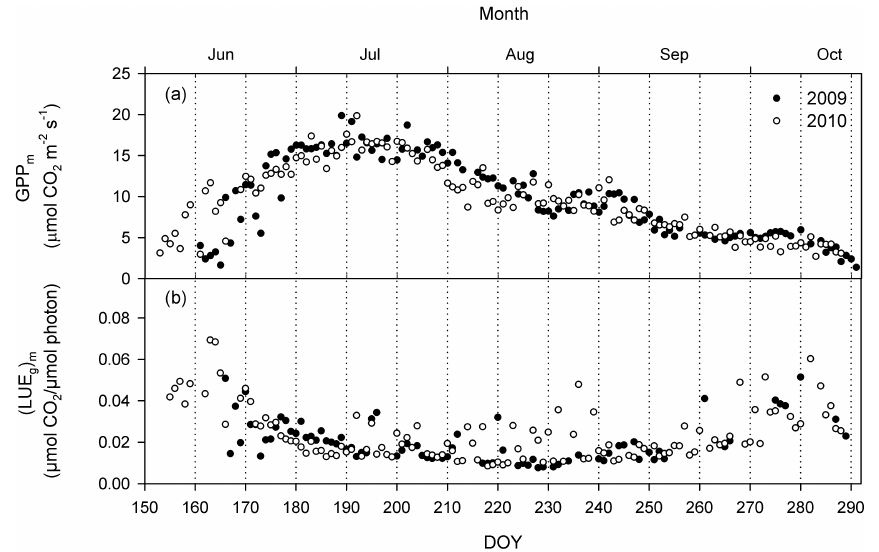
Fig. 5. Seasonal variation of midday carbon variables in 2009 (filled circles) and 2010 (open circles): (a) gross primary production (GPP m , µmolCO 2 m − 2 s − 1 ) and (b) green LUE ((LUE g ) m , µmolCO 2 µmol − 1 photon).